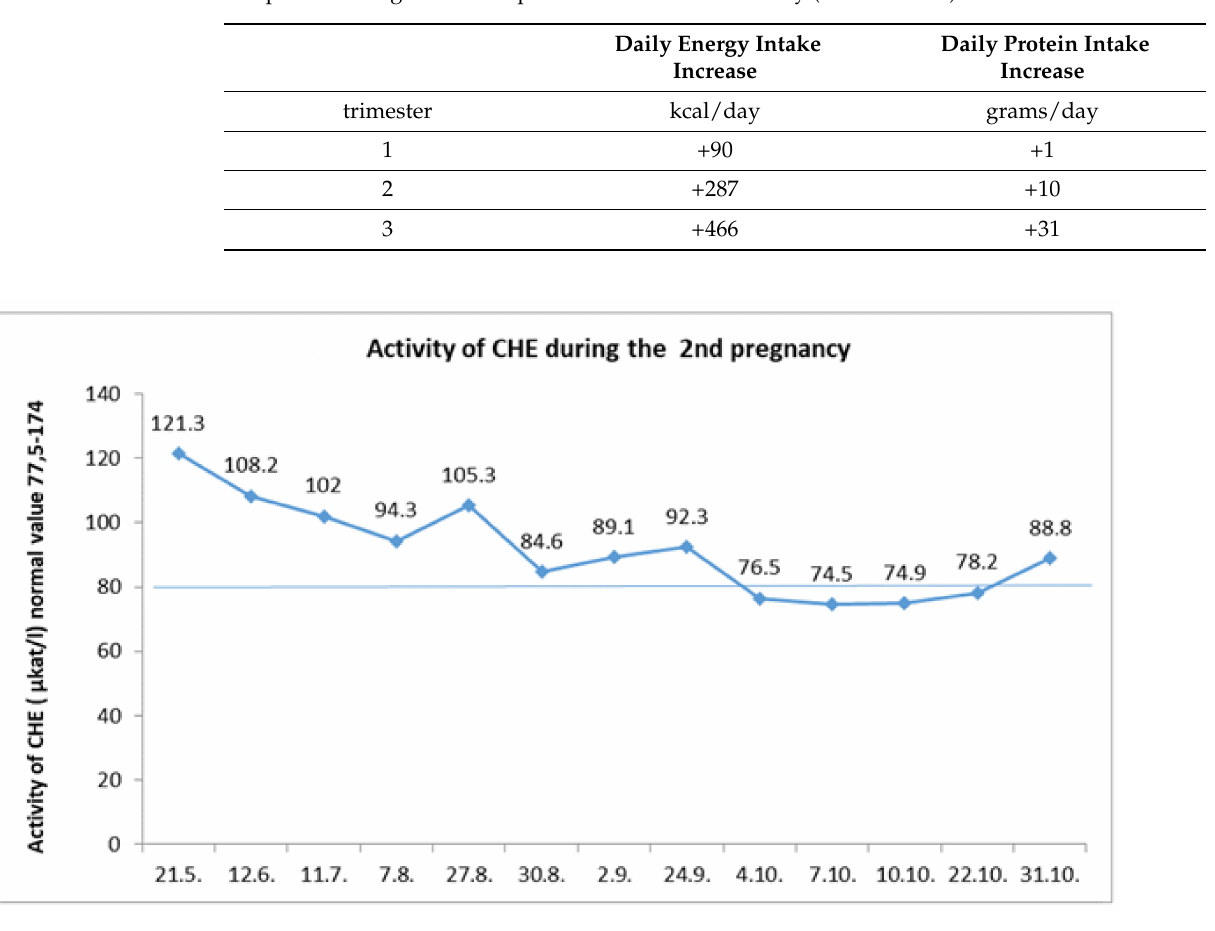
Figure 3. During the second pregnancy, cholinesterase levels were decreasing physiologically, espe- cially during the first trimester. A temporary decrease below the normal values was reported in the third trimester, which recovered